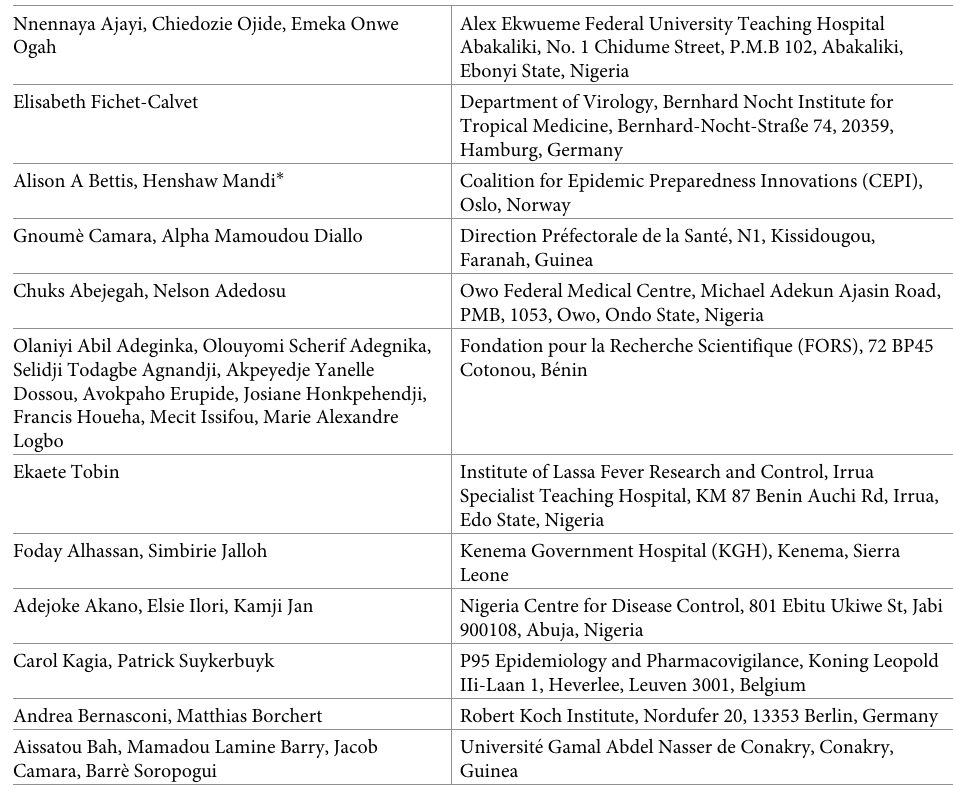
S1 Fig. Enable programme governance